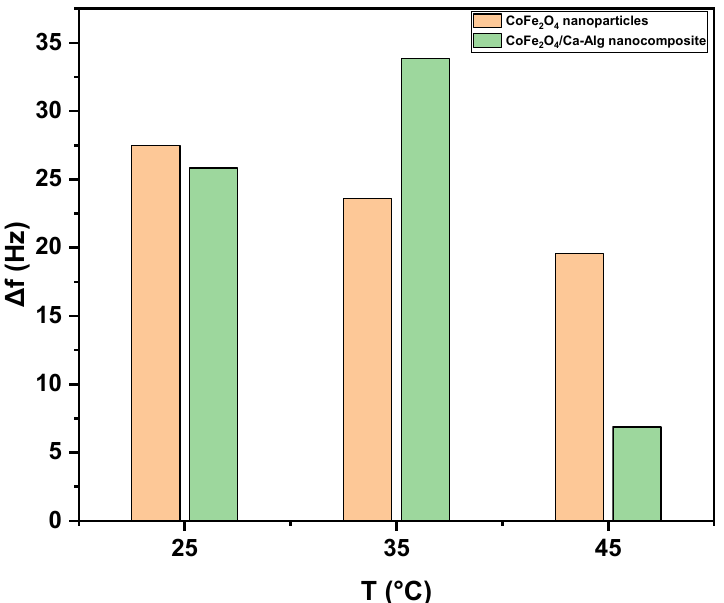
Figure 8. The net frequency shifts of the green synthesized CoFe 2 O 4 nanoparticles and CoFe 2 O 4 /Ca- Alg nanocomposite-coated QCM nanosensors in Pb(II) aqueous solutions as a function of the solution temperature.